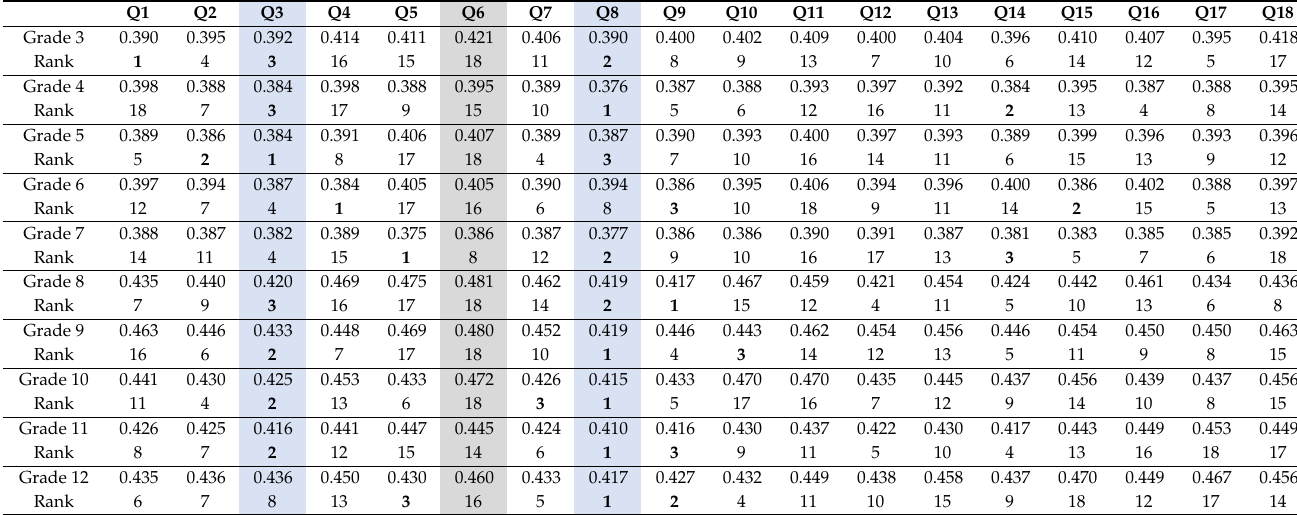
Figure 4. The VGAS criteria analysis for grades 3 to grade 12 with TOPSIS method . Table 7. Overall VGAS criteria ranking across the